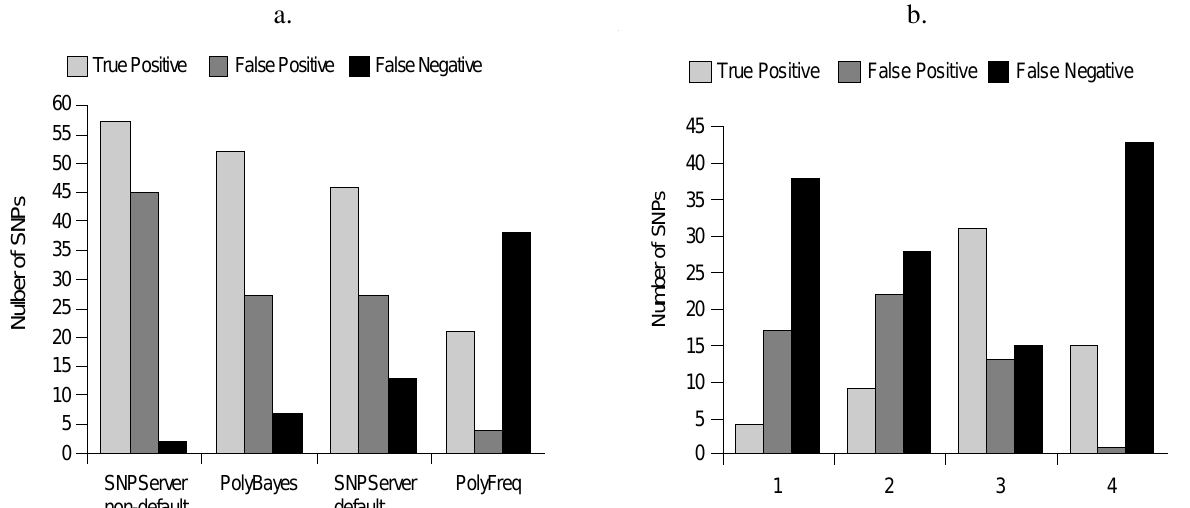
Fig 3: Performance of tools mining for SNPs. a. Number of true positives, false positives and false negatives given by tool. b. Number of true positives, false positives and false negatives given the number of tools used for SNPs